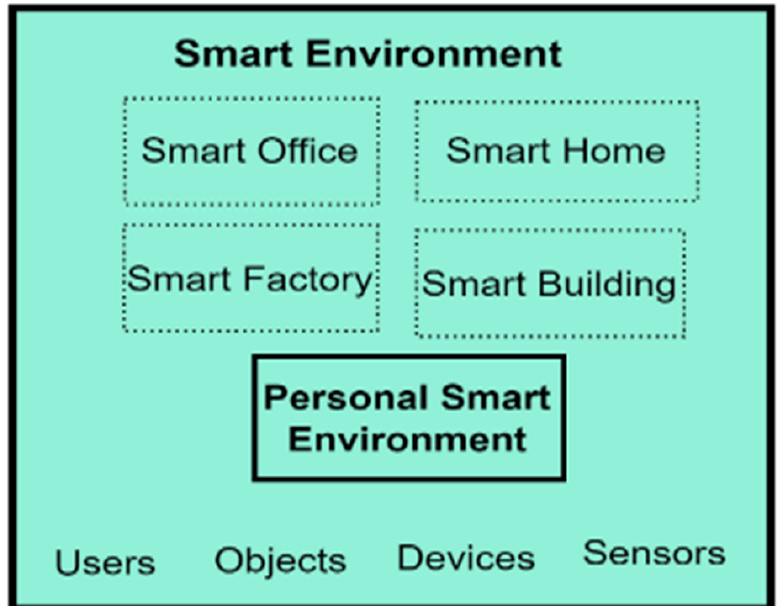
Figure 3. The Expanded SE Component of the PBC Model.